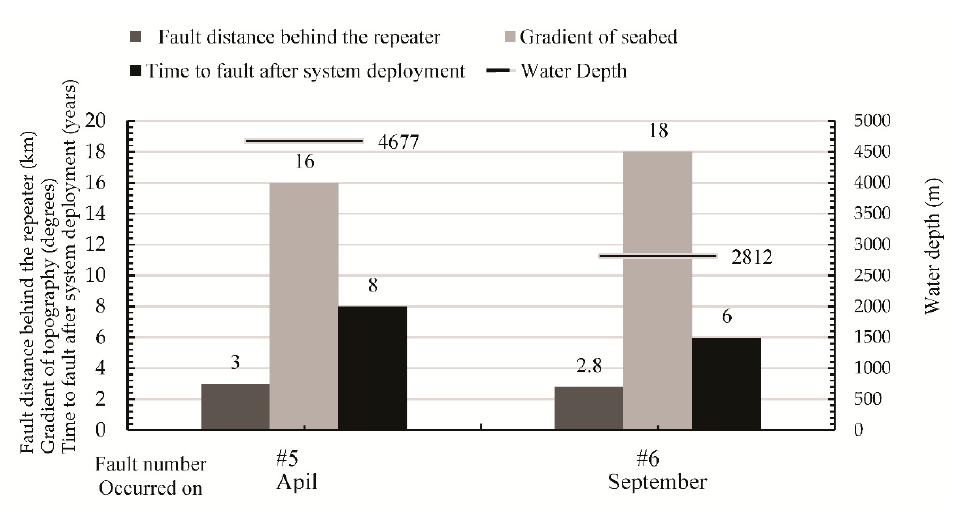
Figure 18. Individual situation of cable faults related to laying repeater in LWS. (3) Details of the fault.